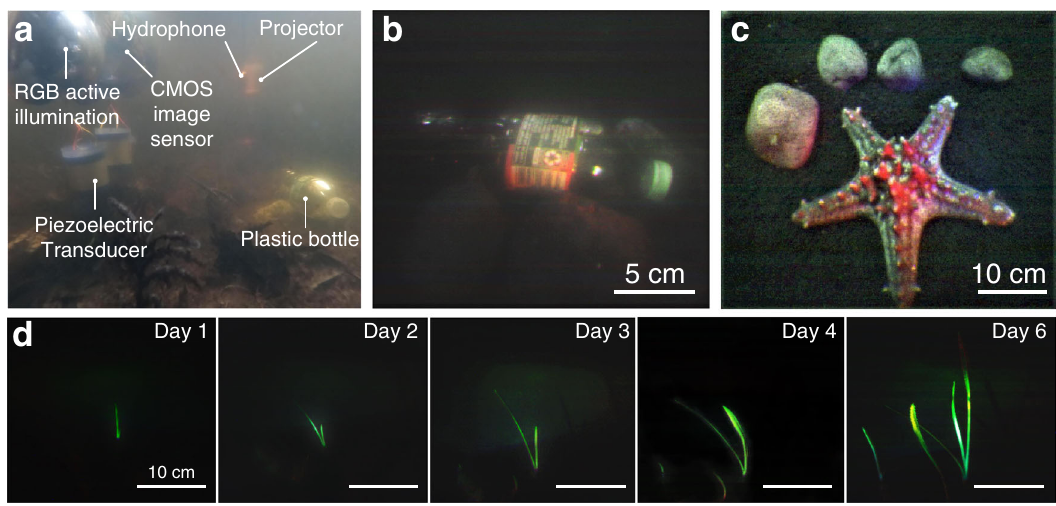
Fig. 3 | Sample images obtained using underwater backscatter imaging. a The fi gure shows a photo of a prototype deployed in Keyser Pond for monitoring pol- lution from plastic bottles on the lakebed. b The RGB image output obtained from the imaging method while monitoring pollution in Keyser Pond. c RGB image